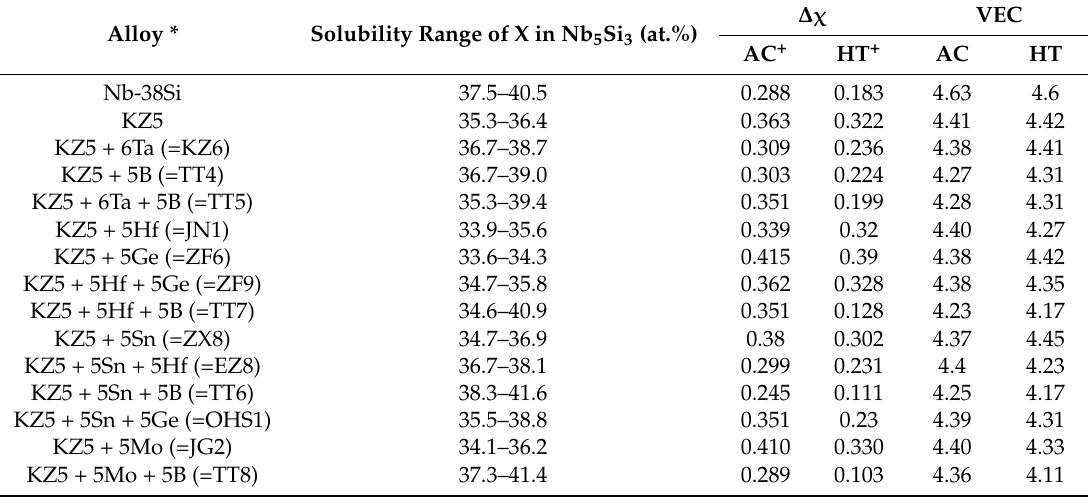
AC + = as cast, HT = heat